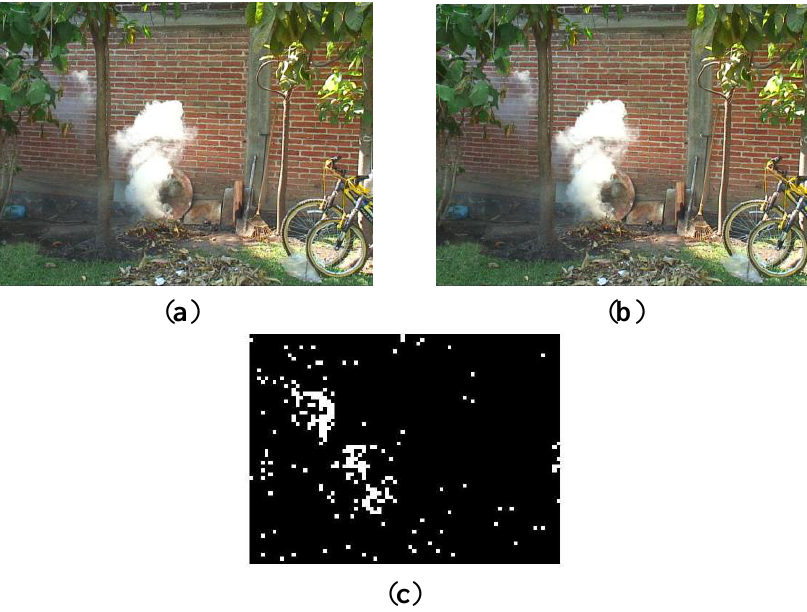
Figure 2. Detection of candidate smoke blocks; ( a ) and ( b ) consecutive frames and ( c ) binary image B . t